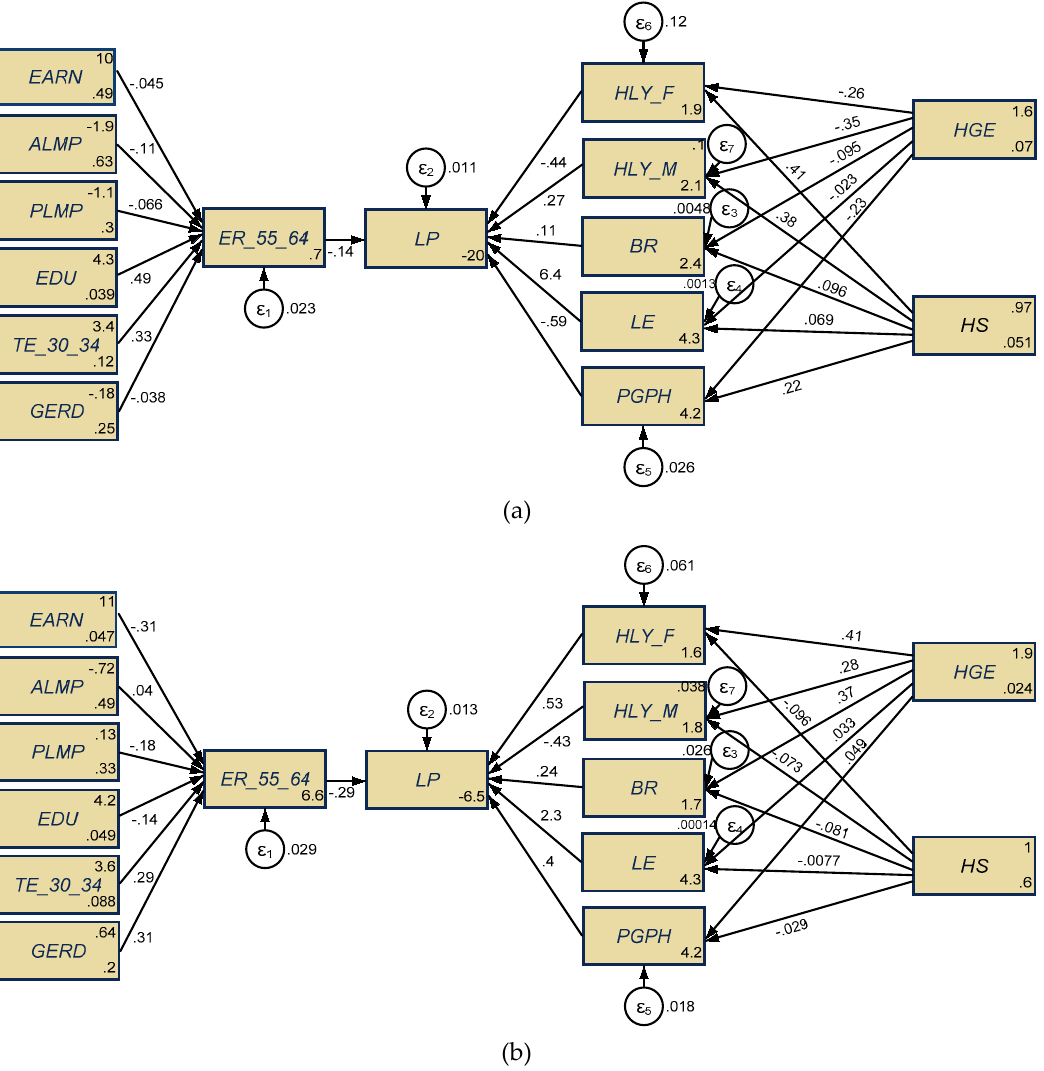
Figure 5. Results of structural equation modeling (SEM) for the EU-13 ( a ) and EU-15 ( b ) panels, 1995–2017. Source: Own contribution in Stata.